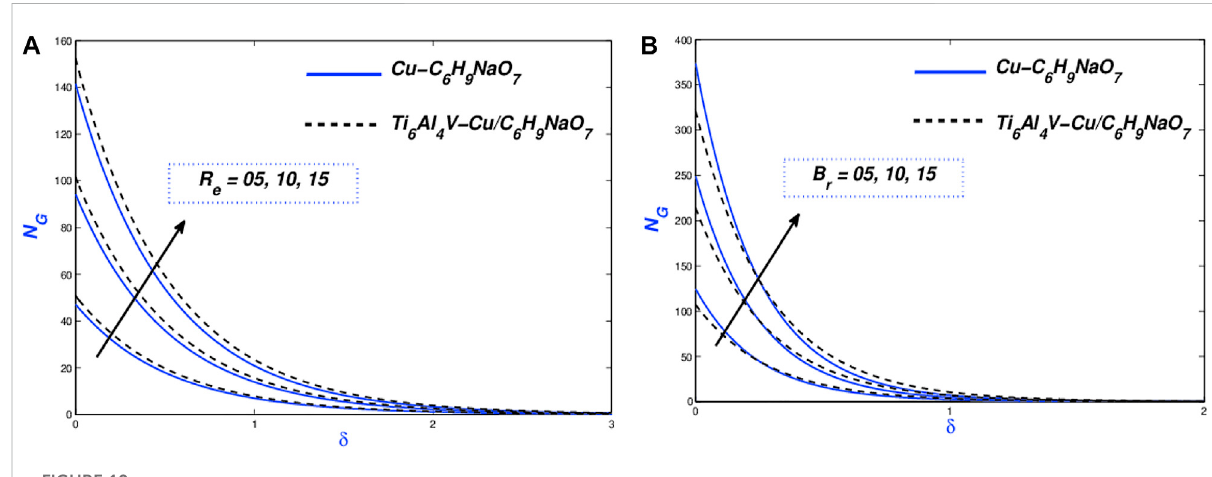
FIGURE 10 N G with diverse (A) R e and (B) B r